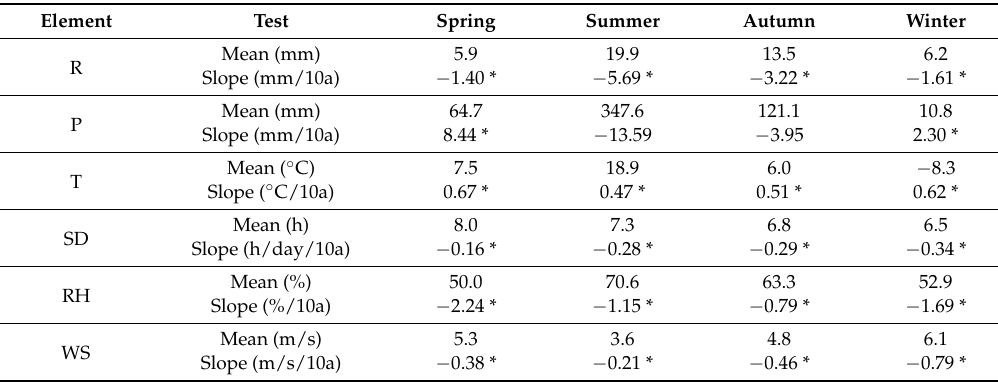
Table 2. The mean value and Mann-Kendall test results of the seasonal R and climatic elements in the HTRB during